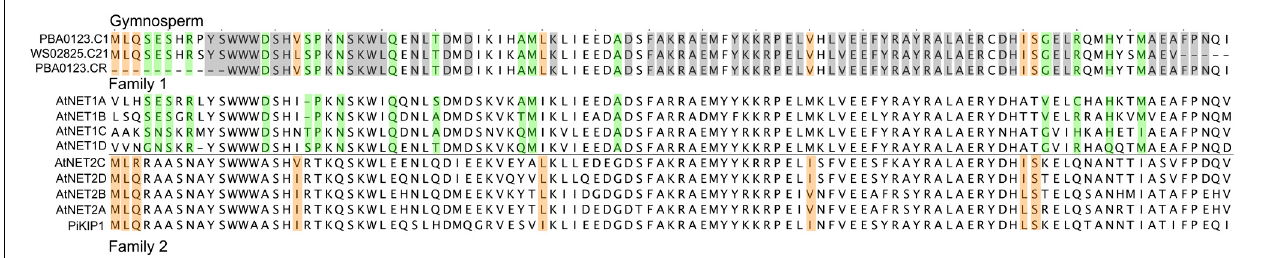
FIGURE 3 | Protein sequence alignment of Gymnosperm NET1/2 hybrid NAB domains with Arabidopsis NET1 and NET2 NAB domains. Gray areas highlight those residues found in both NET1